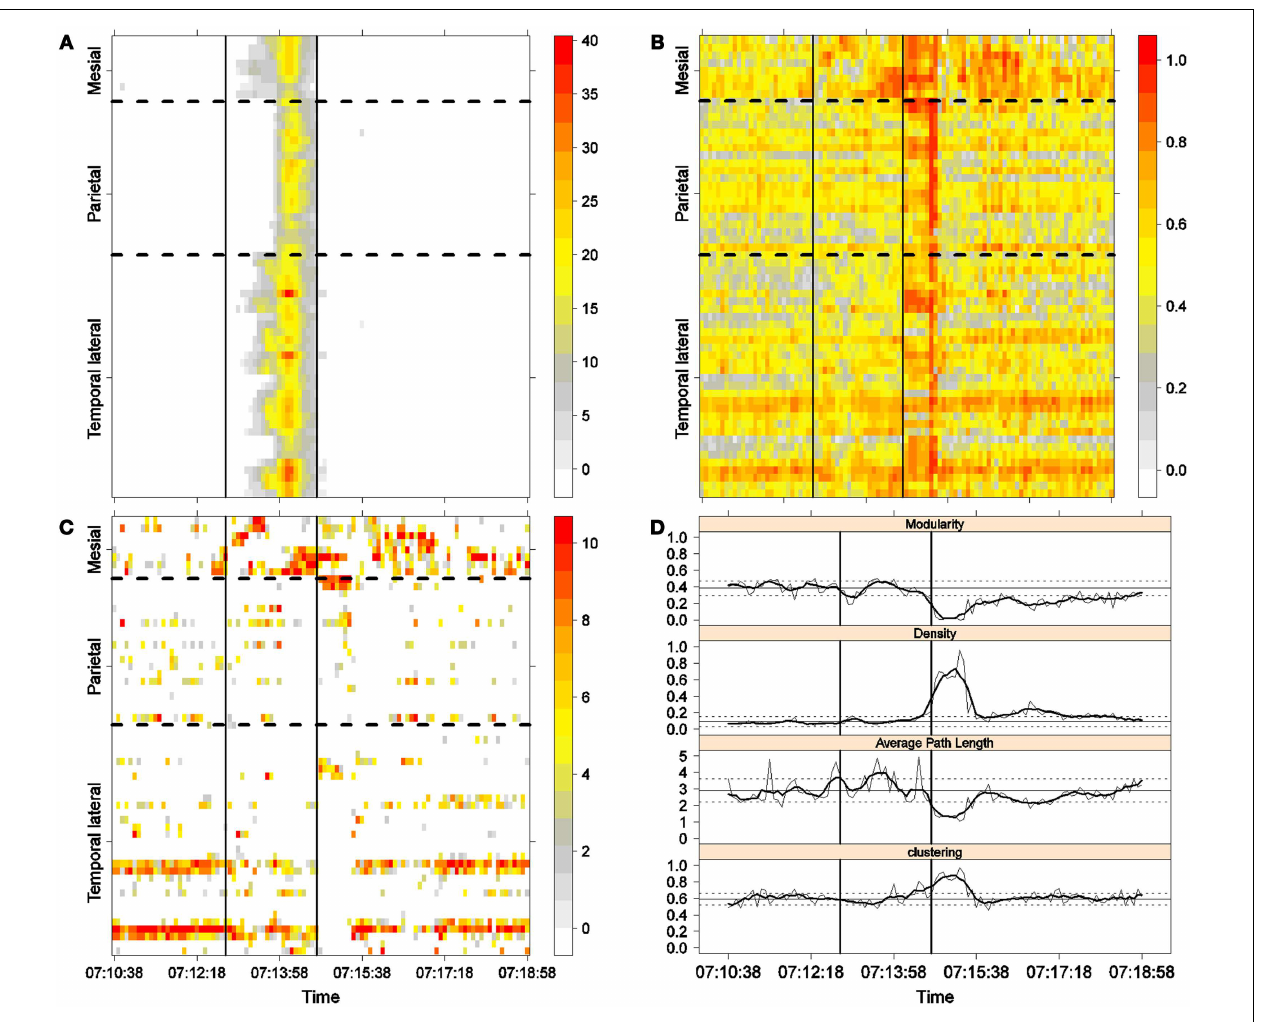
standard deviations of the corresponding measures during the interictal stage. The calculated values for each epoch are indicated by a thin, solid line, and the moving average of five consecutive epochs is shown with a thick, solid